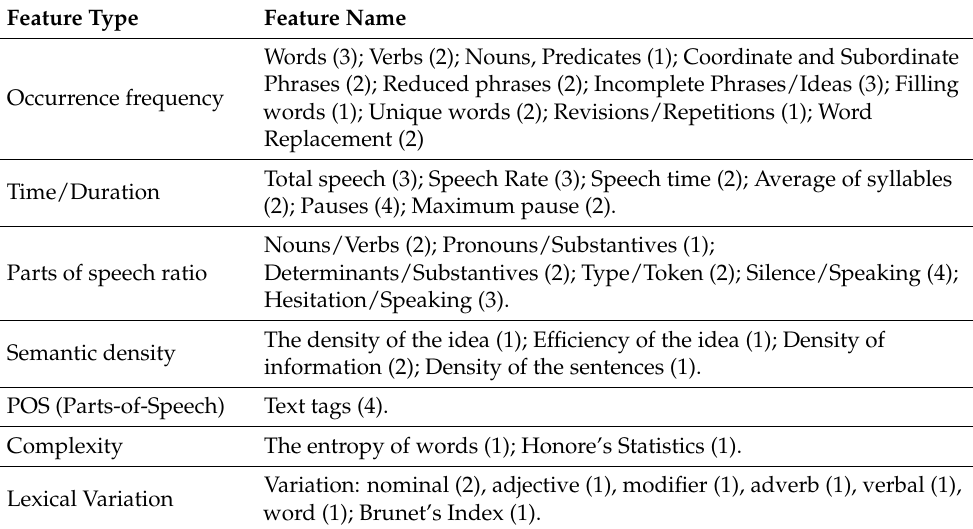
Table 3. Linguistic features that have been used for AD detection. The features are organized by type. For each feature name, the number of occurrences/usages is provided inside